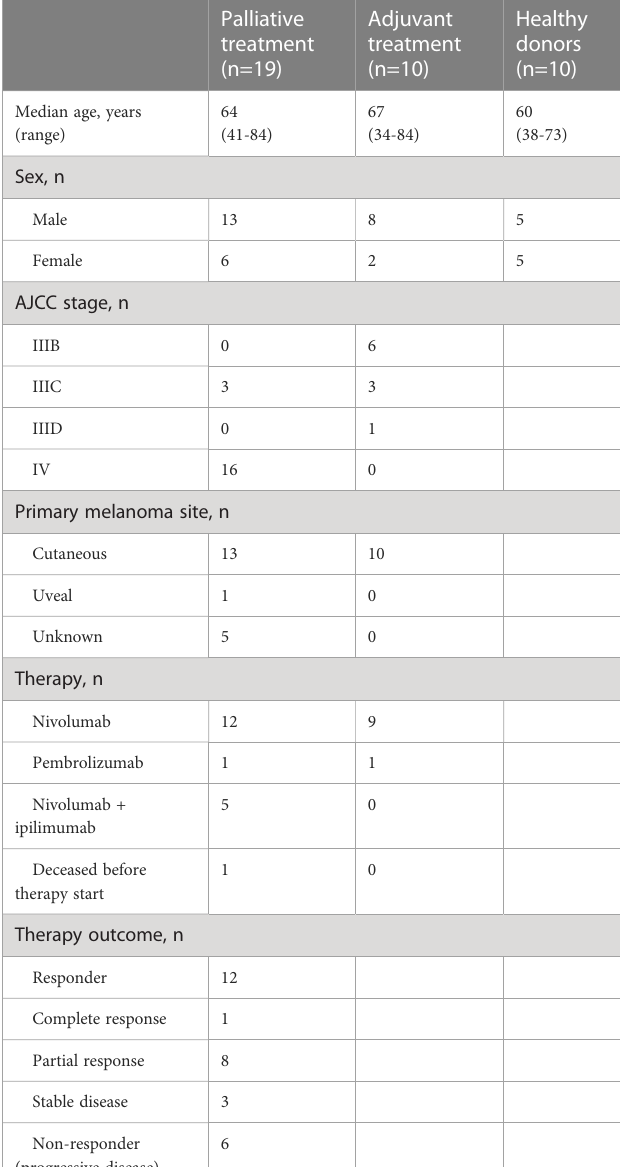
TABLE 1 Clinical characteristics of melanoma patients treated with ICI in palliative and adjuvant